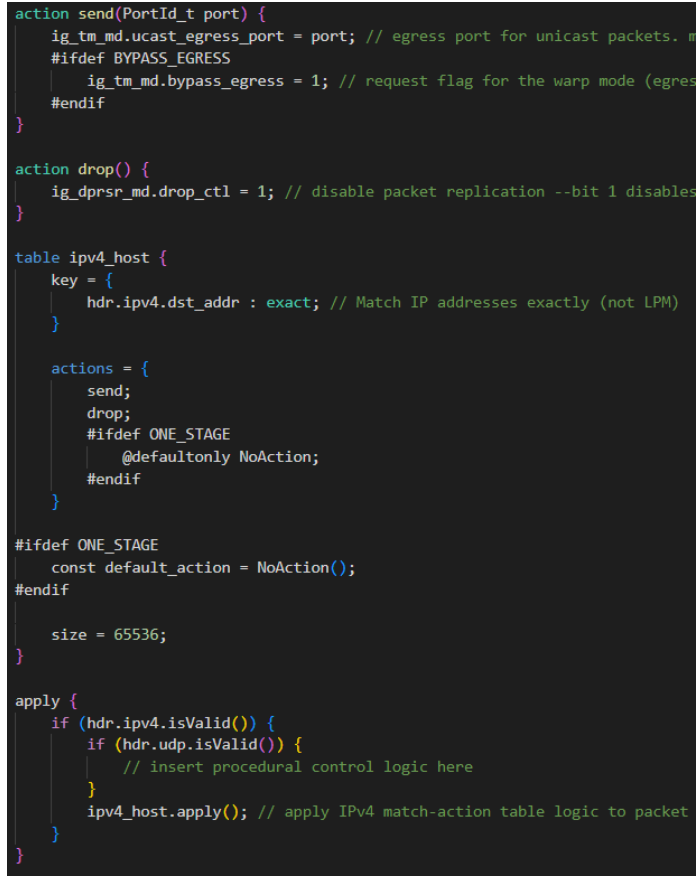
Figure A3. Example Match-Action Pipeline.